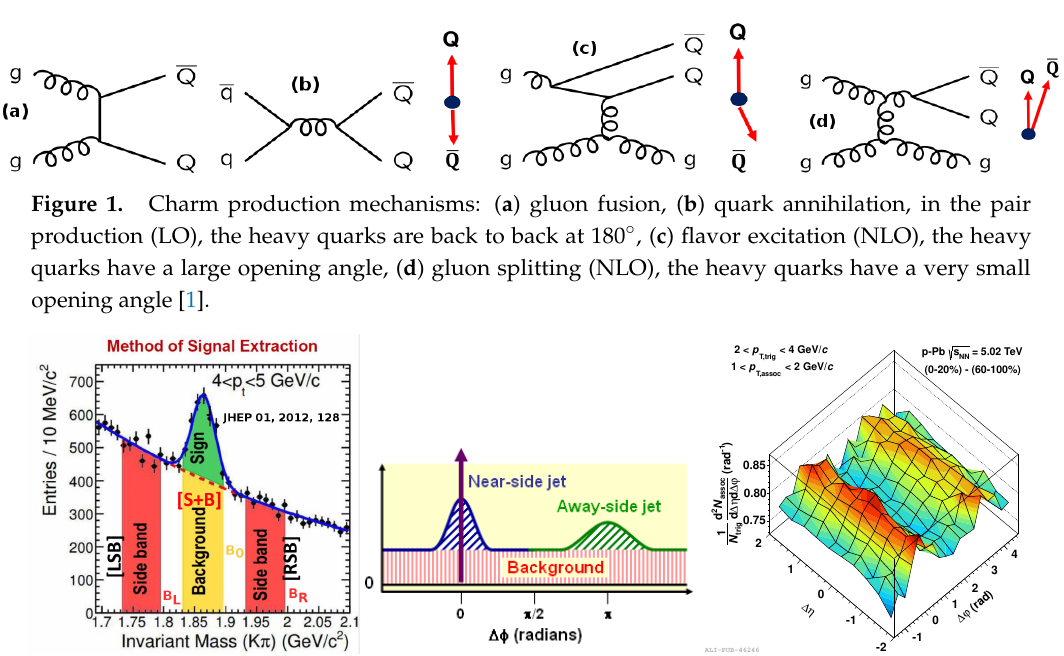
Figure 2. ( Left ) Side-band subtraction from invariant mass distributions, ( Center ): near side, away side peak and baseline [7], ( Right ) The double ridge structure observed in di-hadron correlations